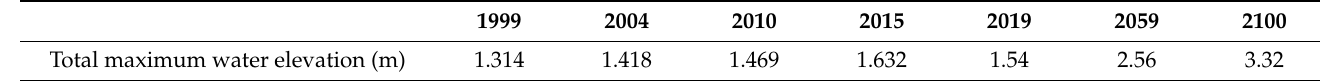
Table 7. Total maximum water elevation.